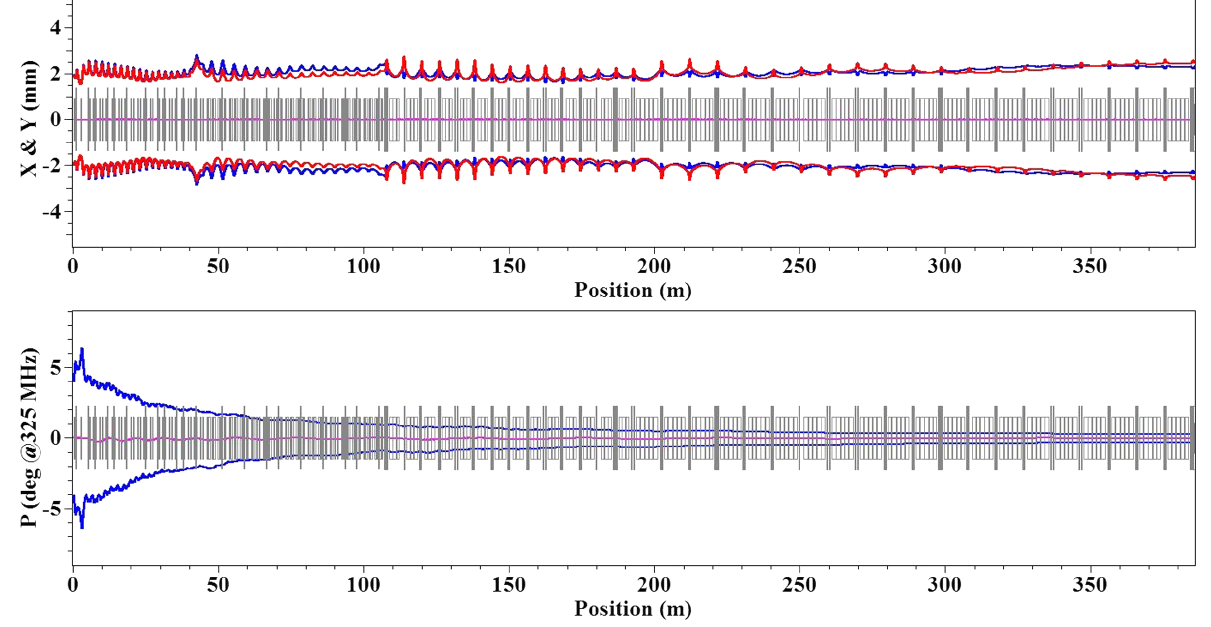
FIG. 22. Root-mean square envelope evolutions in the main linac (upper: X in red, Y in blue; lower: phase width).